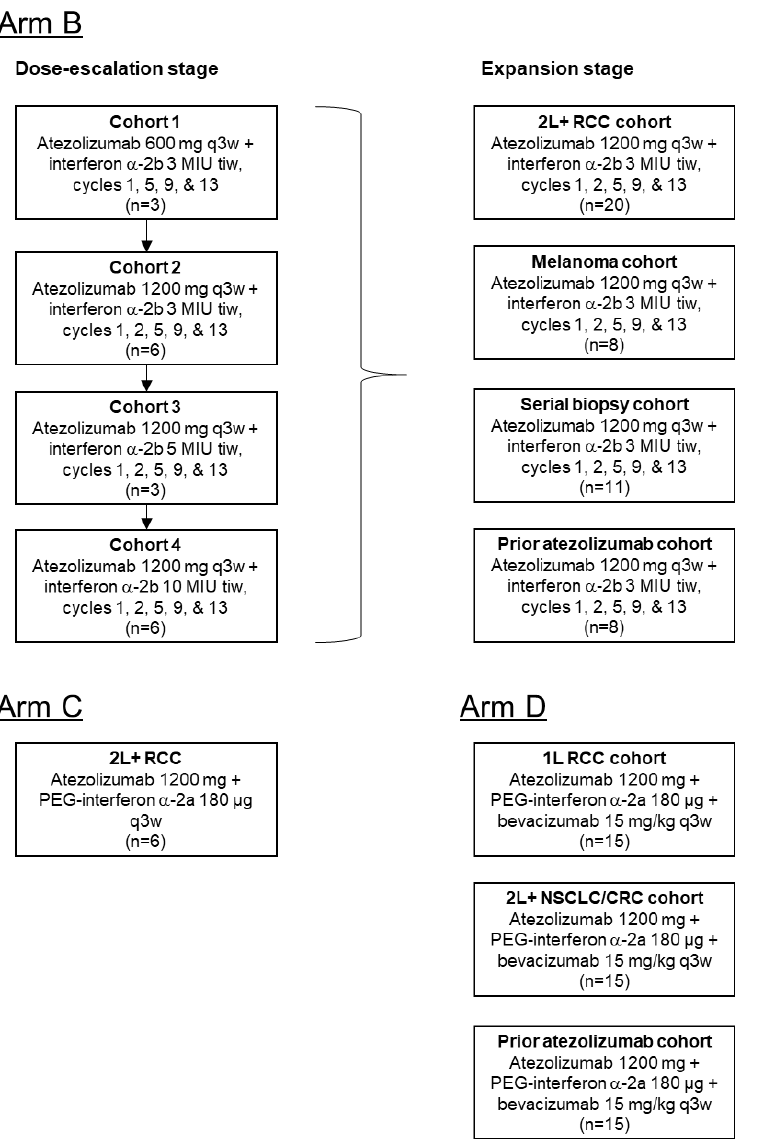
Figure 1. Patient disposition. A total of 116 patients were enrolled into Arms B, C, and D of the study. Arm B recruited 65 patients with previously treated RCC or melanoma into 4 cohorts, with each cohort receiving different dosing regimens of atezolizumab + interferon-a-2b in the initial dose- escalation stage. At the dose expansion stage, patients in Arm B received atezolizumab 1200 mg q3w + interferon a-2b 3 MIU tiw. Arm C comprised 6 patients with previously treated RCC, and they received atezolizumab 1200 mg + PEG-interferon a-2a 180 µg q3w. Arm D recruited 45 patients into 3 cohorts, with each patient receiving atezolizumab 1200 mg + PEG-interferon a-2a 180 µg + bevaci- zumab 15 mg/kg q3w. MIU, million international units; q3w, every 3 weeks; tiw, 3 times per week. The majority of patients were white (84.5%), male (76.7%), had an ECOG perfor- mance status of 0 (72.4%), and did not have detectable PD- L1 expression on ≥1% of tumor - infiltrating immune cells (46 – 67%) or tumor cells (62 – 83%) (Table 1).